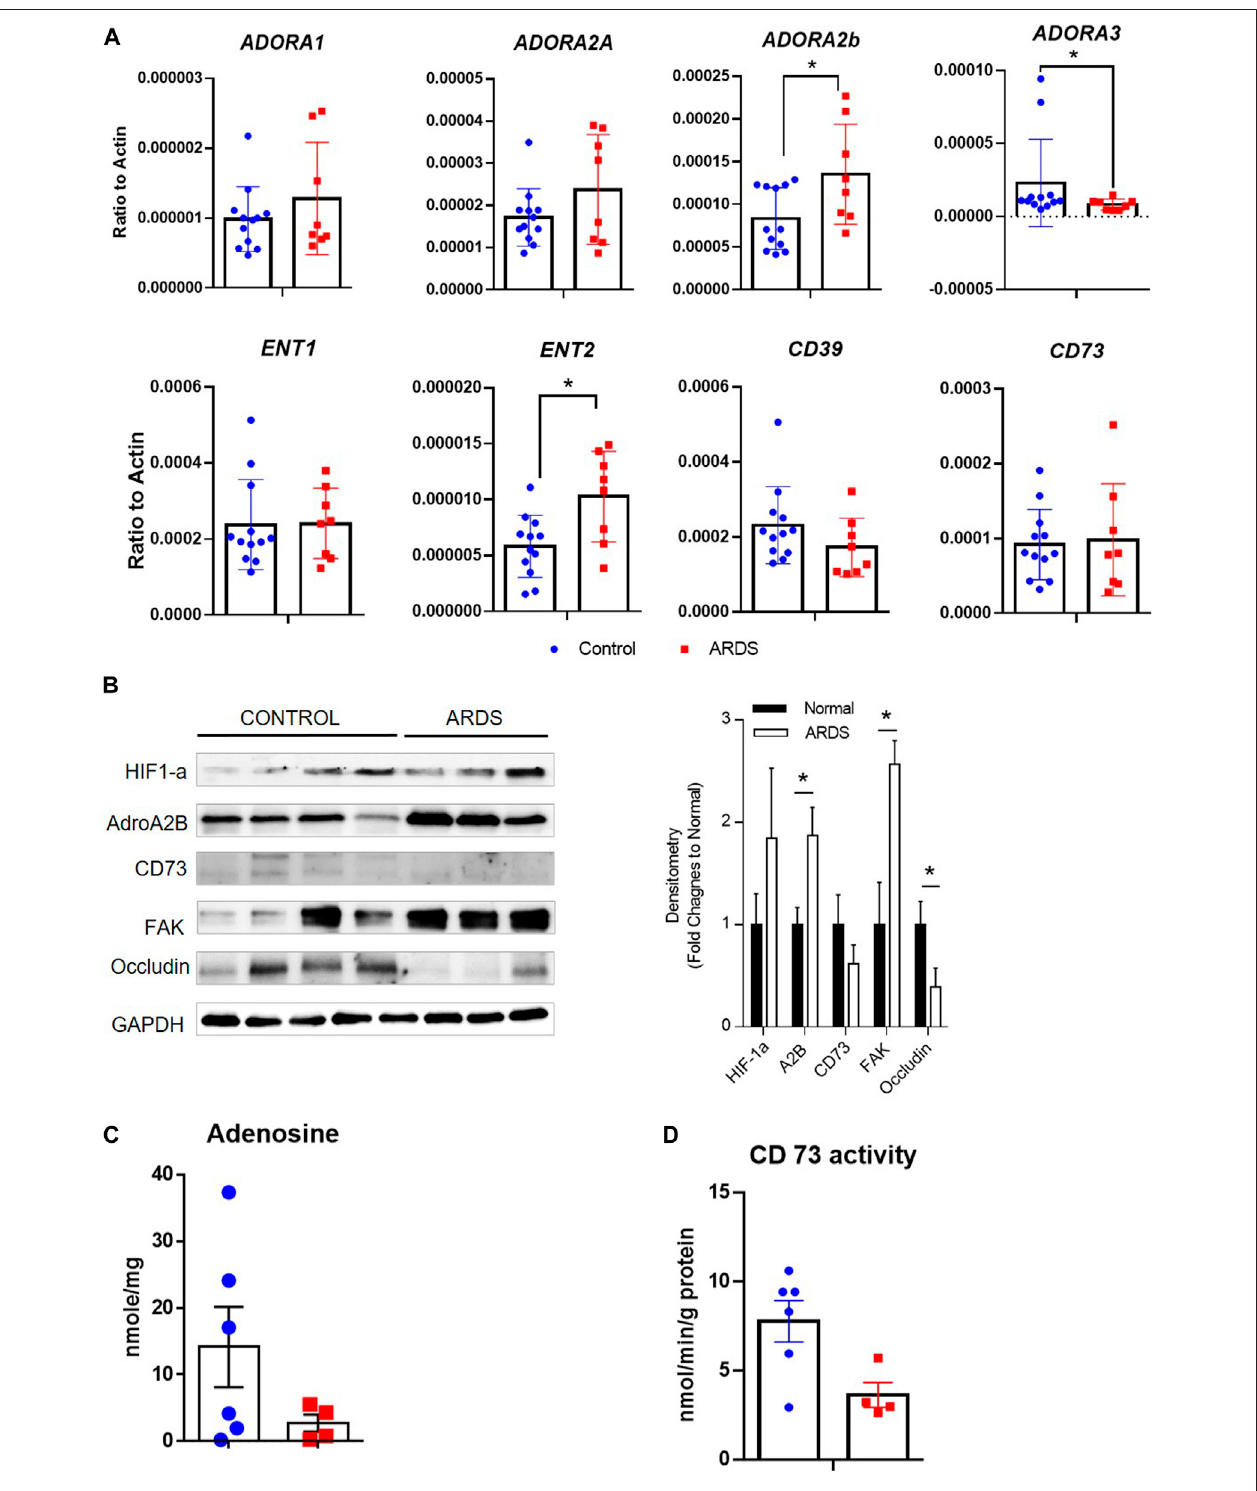
FIGURE8| Expressionofadenosinereceptors, transportersandenzymesinhumanARDSlungs. (A) Thetranscript expressionofadenosinereceptors(ADORA1, ADORA2A, ADORA2B and ADORA3), transporters (ENT1 and ENT2) as well as enzymes (CD39 and CD73) were determined in human normal and ARDS lungs using realtime PCR. (B) Left Panel: The protein expression of HIF-1a, ADORA2B, CD73 as well as tight junction proteins were determined in normal and ARDS lungs using westernblot.RightPanel:DensitometryoftheWesternBlotimagewereanalyzedanddatawerepresentedasfoldchangestoNormalcontrol ± MSE.* p < 0.05. (C) The levels of adenosine were measured using HPLC. (D) The activities of CD73 were determined in control and ARDS lungs. * p < 0.05 using student t-test.